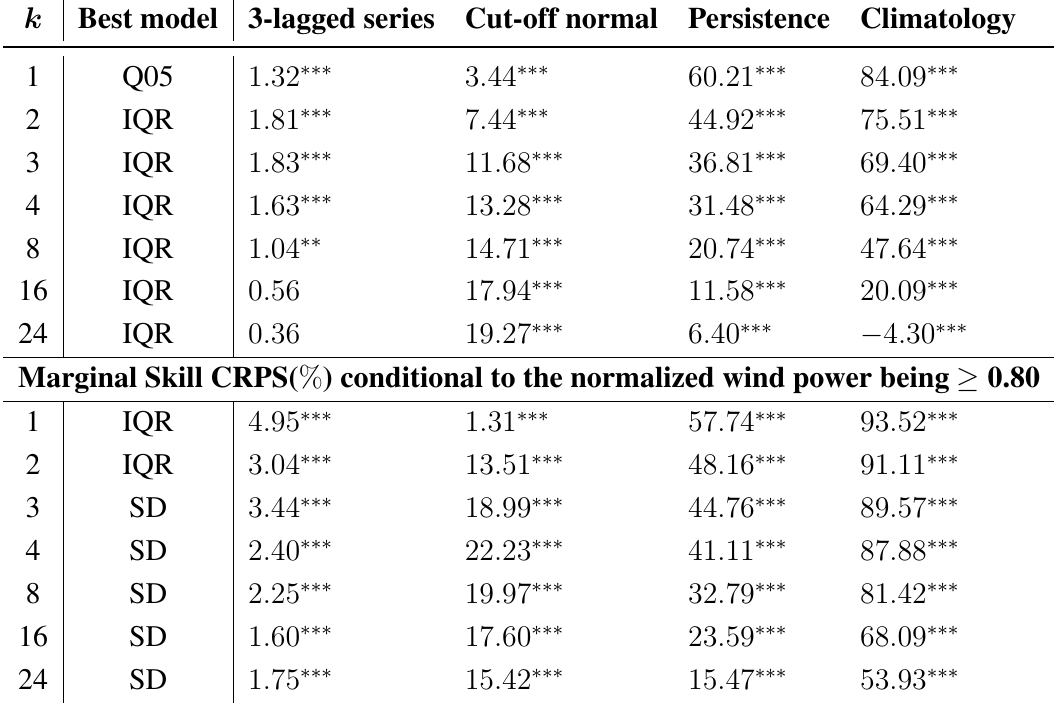
Table 11. The best performing model (according to the Marginal Skill CRPS) among the four competing ones, and its performance gain/loss with respect to the four reference (benchmark) models, for forecast horizon k (measured in 15 min steps). Reference models: 3-lagged series (column 3), Cut-off normal (column 4), Persistence (column 5) and Climatology (column 6). These results are outcomes from a 1-step ahead CFS optimization. The asterisks indicate the statistical significance of the gain/loss according to the Amisano and Giacomini test with the following significance codes for the p -value of the test: ***: p ≤ 0 . 01